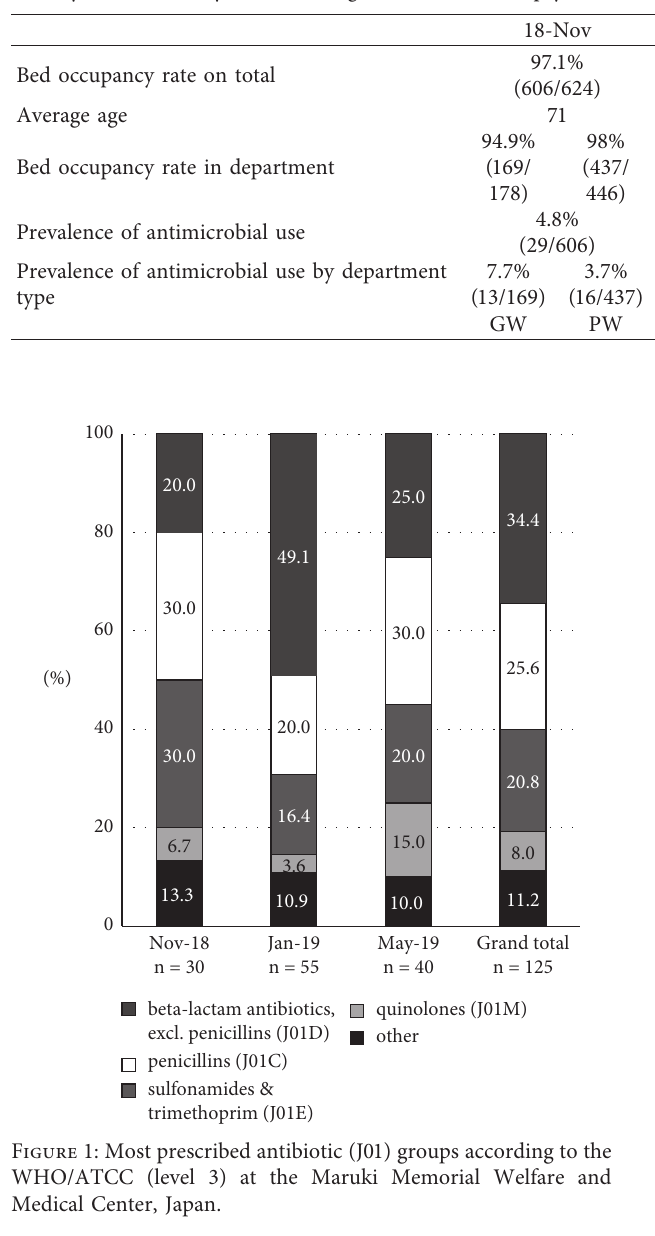
Table 1: Bed occupancy and antimicrobial use prevalence at the Maruki Memorial Welfare and Medical Center, Japan, in November 2018, January 2019, and May 2019 (GW � general ward; PW � psychiatric ward).